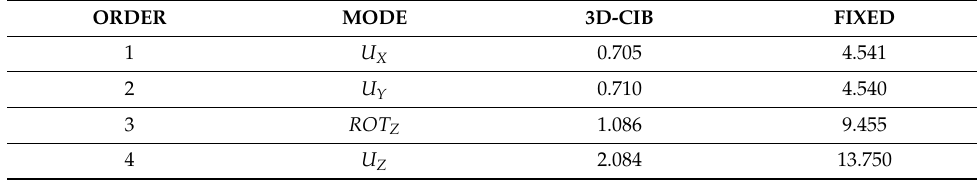
Table 2. Comparison of the natural frequencies of vibration.